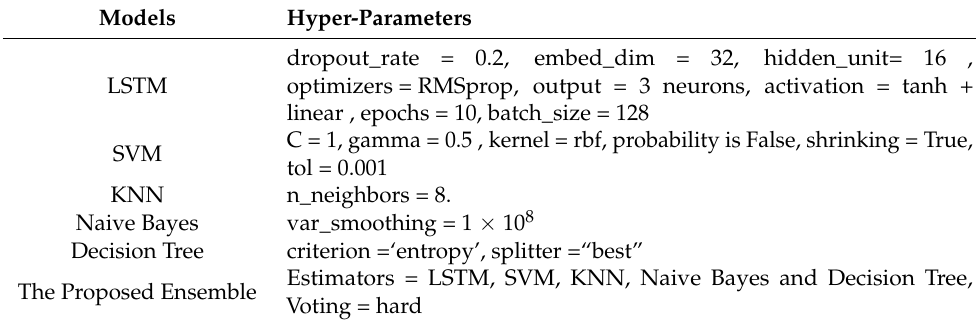
Table 1. Hyper-parameters of the models.